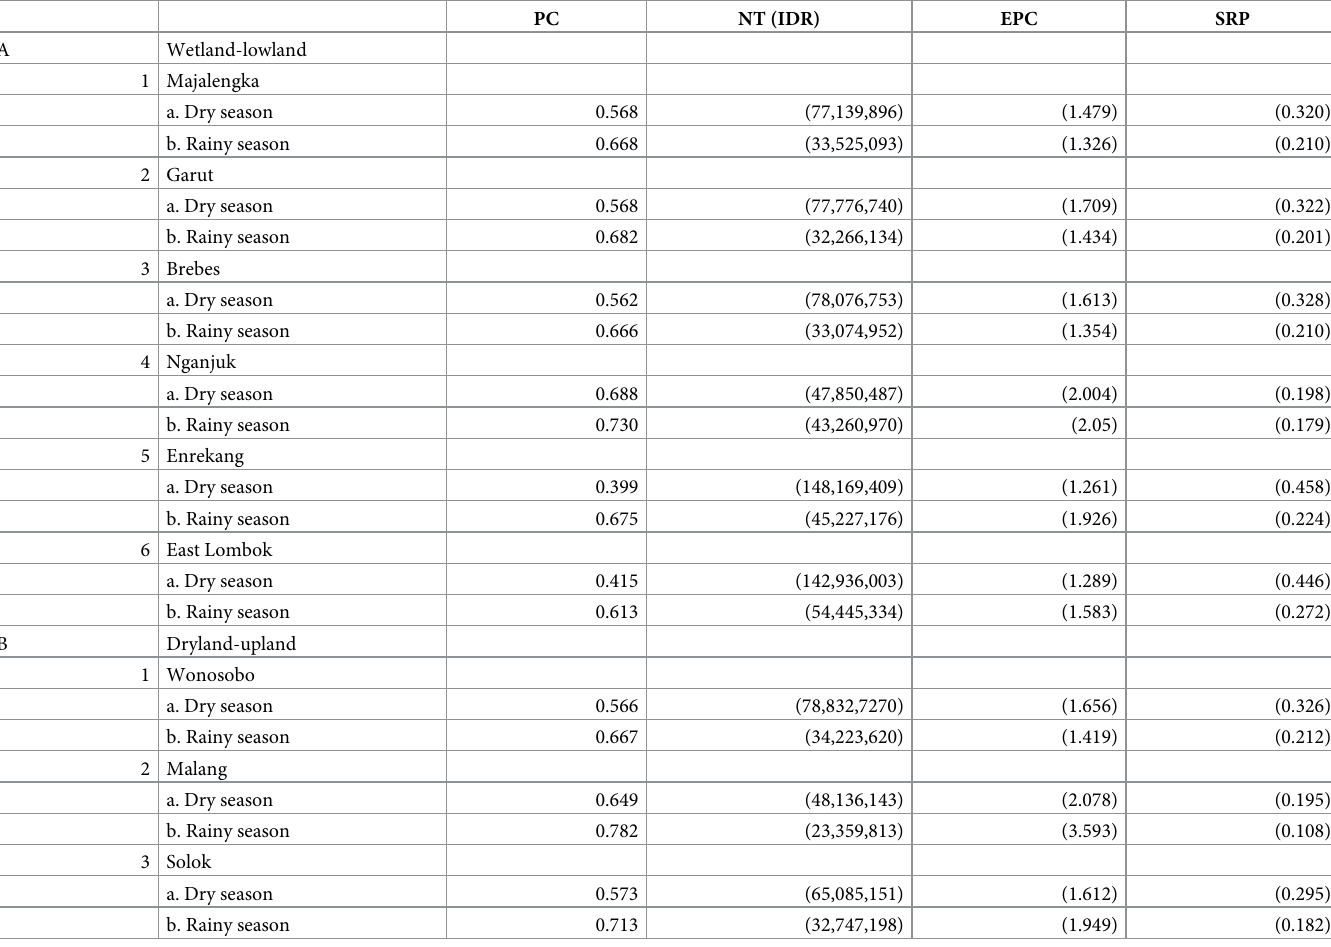
Table 6. Values of NT, PC, EPC and SRP of shallot farming per ha per season in Indonesia’s shallot production centers, dry season 2019 and rainy season 2019/